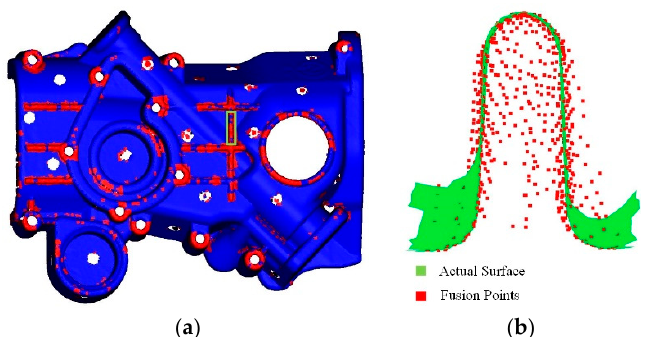
( b ) Figure 9. The 2D representation of the critical points identification method; the solid black line represents the actual surface; the neighborhood of voxel v is divided into two sets; ( a ) voxel v , positive set { v 5 }, negative set { v 1 , v 2 , v 3 , v 4 , v 6 , v 7 , v 8 }, positive set and negative set constitute two connection groups Γ 1+ and Γ 2 − (red and blue circle), so v is not a critical point; ( b ) the voxel v , positive set { v 2 , v 3 , v 4 , v 6 , v 7 , v 8 } and negative set { v 1 , v 5 }; the two sets are divided into four connection groups Γ 1 − , Γ 2+ , Γ 3 − , and Γ 4+ , so v is a critical point (there are four groups in 2D, but only three in 3D).